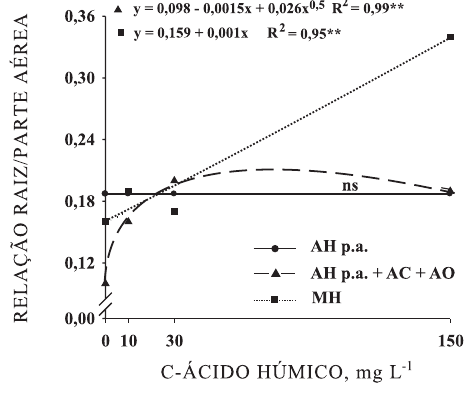
Figura 4. Razão matéria seca de raiz/parte aérea de mudas de eucalipto em resposta ao aumento de